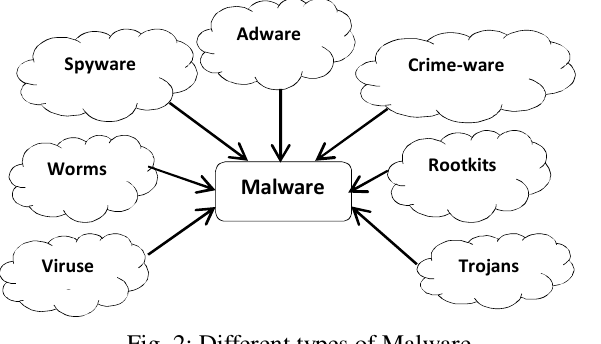
Fig. 2: Different types of